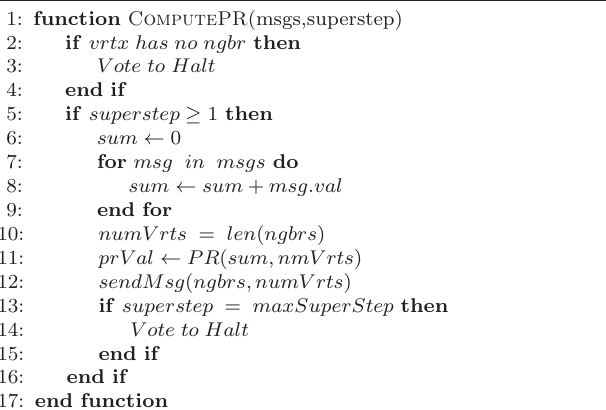
Algorithm 3 Vertex-Centric Implementation of